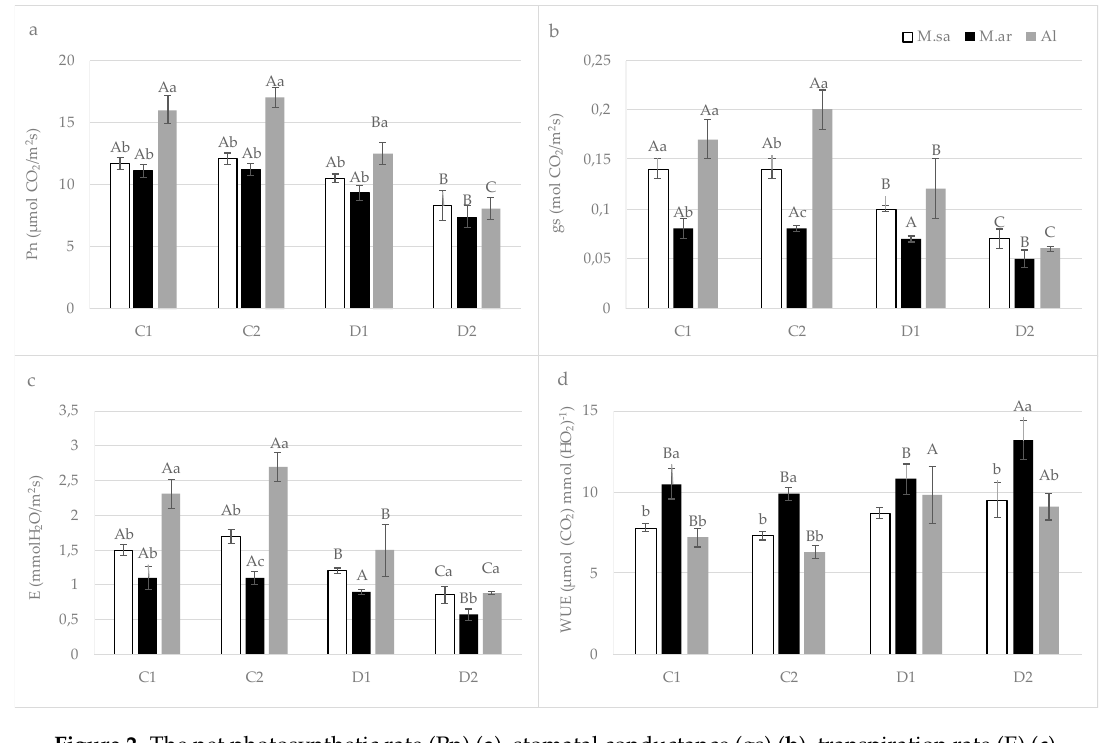
Figure 2. The net photosynthetic rate (Pn) ( a ), stomatal conductance (gs) ( b ), transpiration rate (E) ( c ) and Water Use Efficiency (WUE) ( d ) as the rate Pn/E of M. arborea (M.ar), M. sativa (M.sa) and Alborea (Al) under control (C) and drought stress (D) after the 1st (C1 and D1) and 2nd (C2 and D2) week of drought. Error bars indicate the mean ± SE of four independent samples. The different capital letters refer to the significant differences between the same entries among the treatments (C & D) at p < 0.05 (Tukey test). The different small letters refer to the significant differences between the entries in the same treatment at p <0.05 (Tukey test).